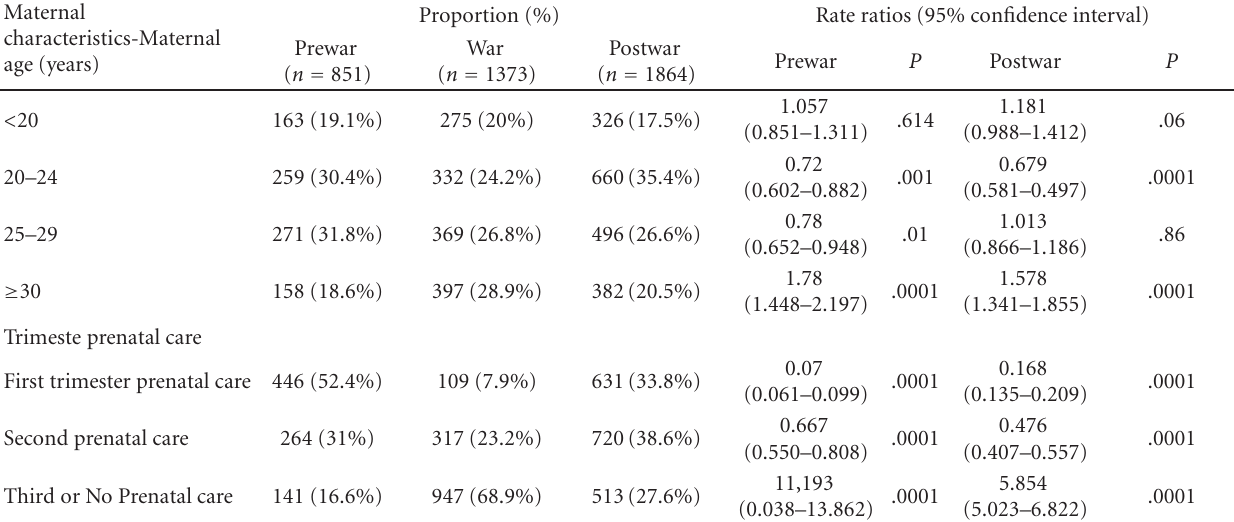
Table 2: Maternal age and prenatal care of follow up and birth data for Low birth weight at University Clinical Center of Tuzla, Department for Gynecology and Obstetrics in the prewar (1988–1991), war (1992–1995), and postwar (1996–2009) period.